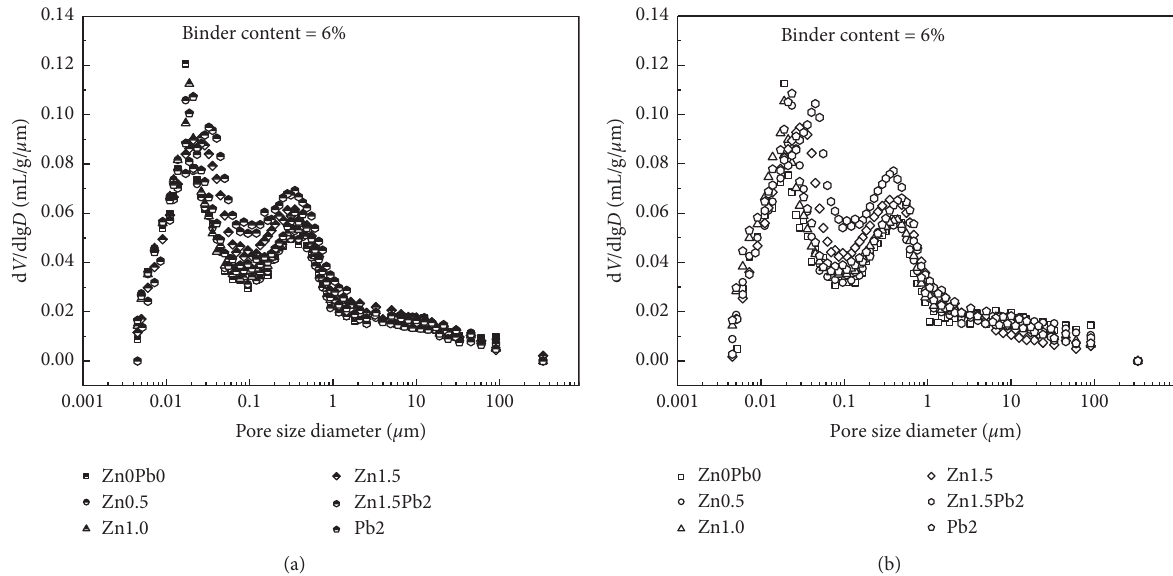
Figure 8: Pore size distribution of the stabilized soils cured for 28d: (a) KMP and (b)